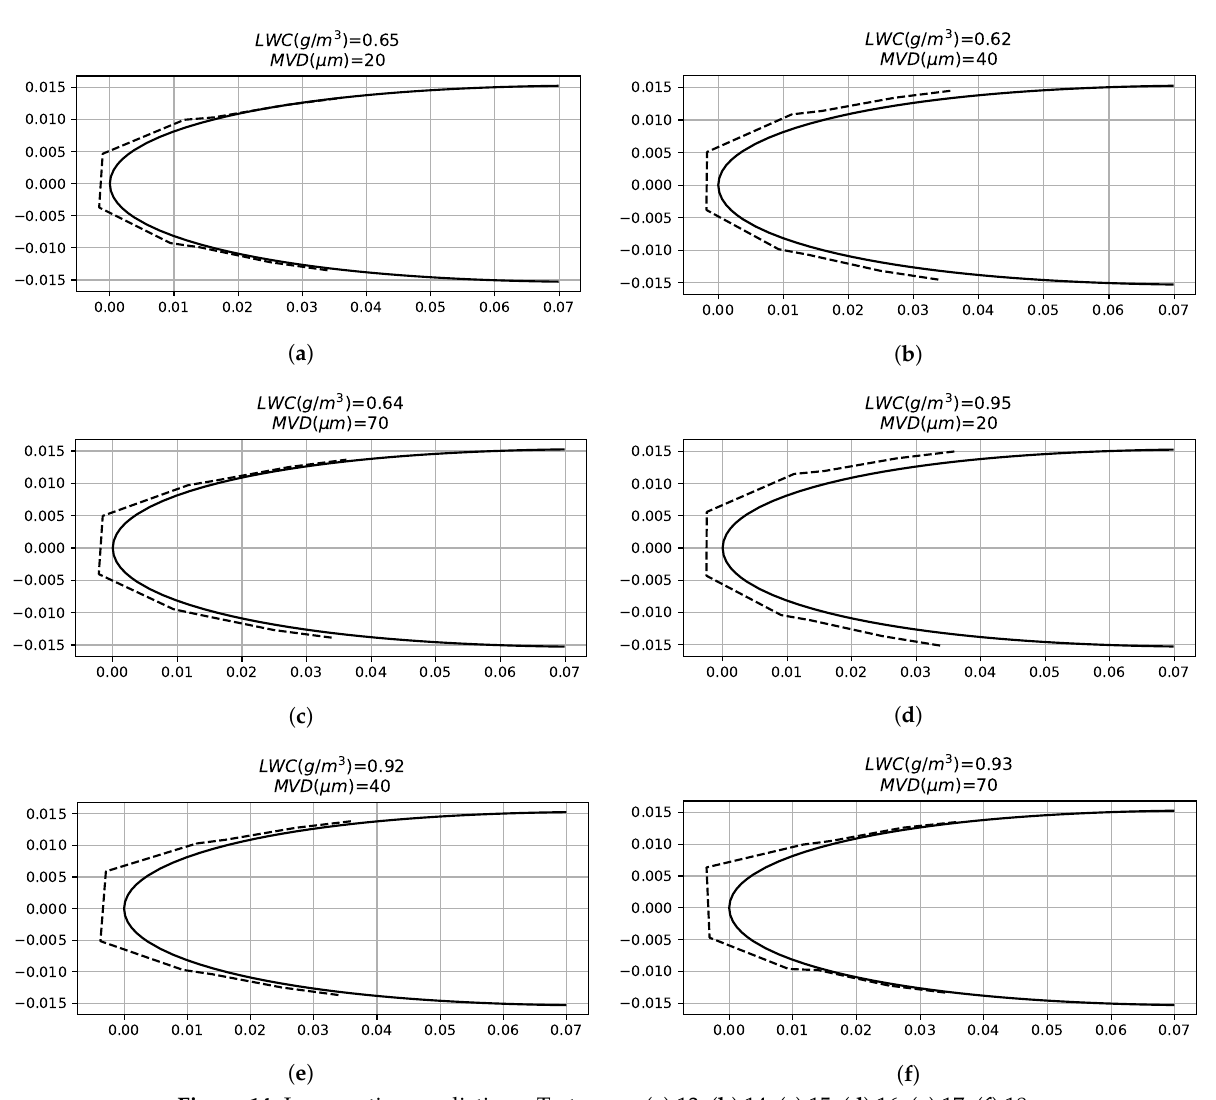
Figure 14. Ice accretion predictions. Test cases: ( a ) 13, ( b ) 14, ( c ) 15, ( d ) 16, ( e ) 17, ( f )